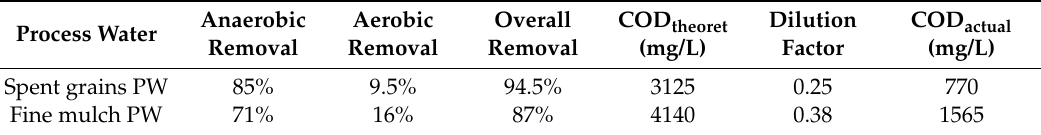
Table 2. Chemical oxygen demand (COD) removal in the biological stages and residual concentrations of refractory